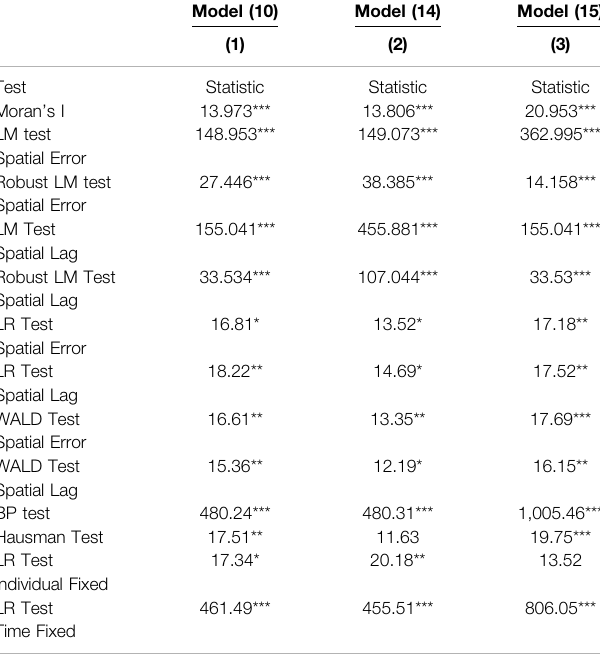
TABLE 7 | LM test, LR, WALD, BP, HAUSMAN test results.